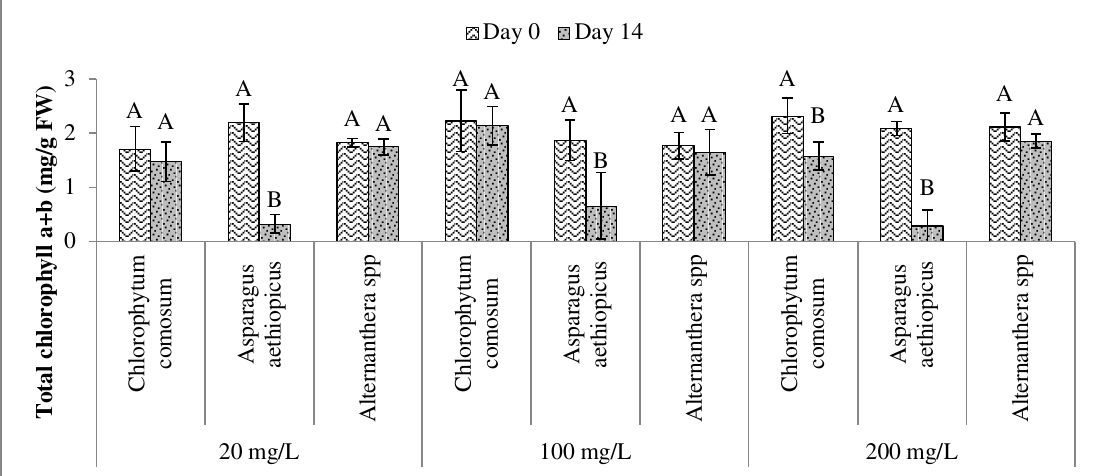
Fig. 3. Total chlorophyll content (a+b) in acetaminophen-exposed systems. Error bars refer to standard deviation